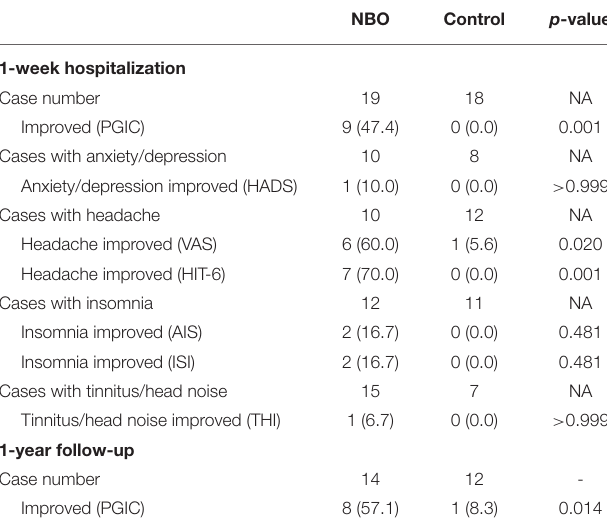
TABLE 2 | Clinical outcomes of CVOD patients in the NBO group and the control